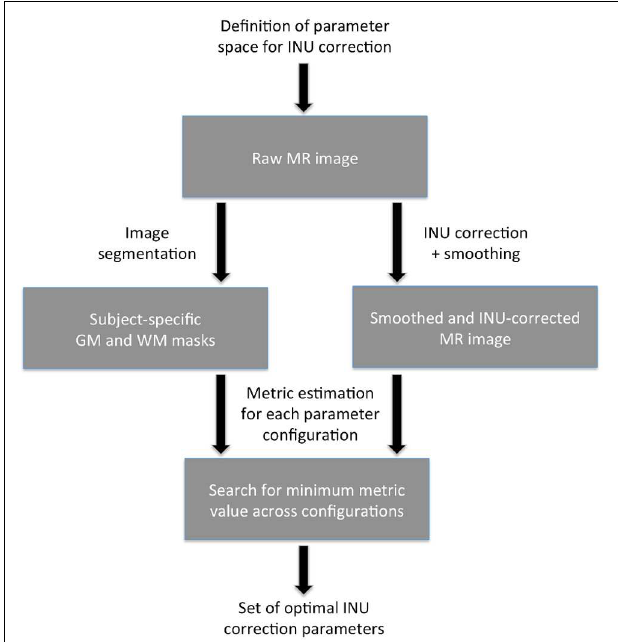
FIGURE 1 | Flowchart of the data-driven approach. The set of optimal intensity non-uniformity (INU) correction parameters is identified by searching the minimum performance metric value (either CV WM , CV GM , or CJV) across values obtained for each combination of the parameters under investigation. The metric value is calculated using subject-specific GM and WM masks and the smoothed INU-corrected MR